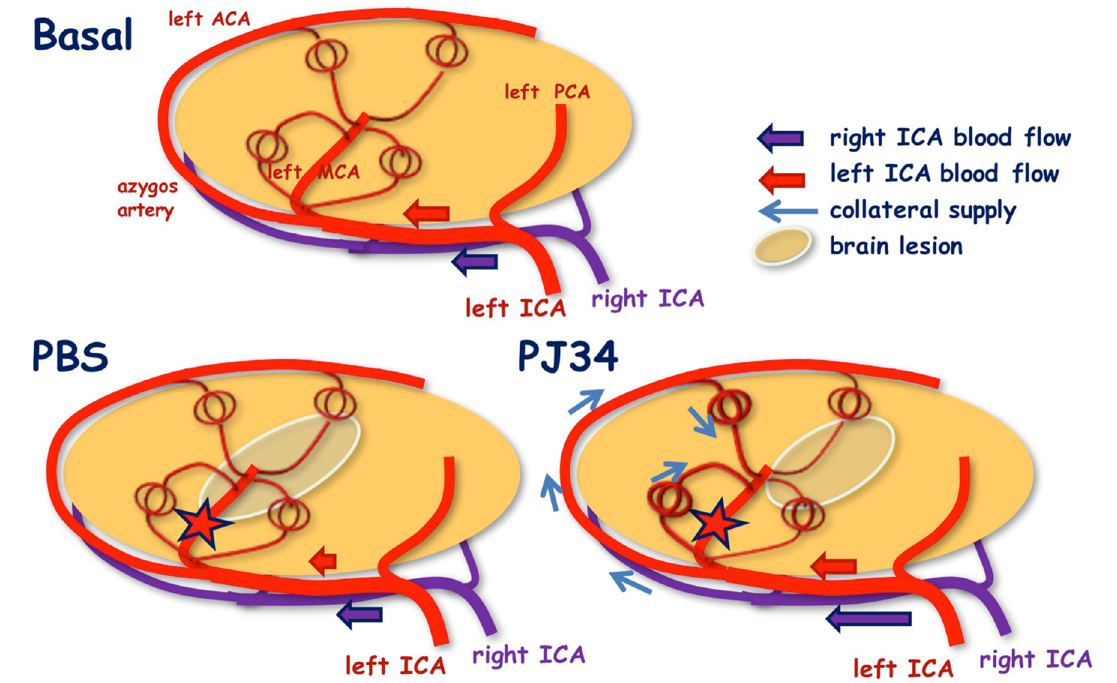
Figure 6. Schematic representation summarizing blood flow re-routing after pMCAo and treatment. After PBS, blood flow is reduced in the left ICA with no collateral flow. After PJ34, blood flow remained stable in the left ICA and increased in the right ICA, leading to collateral supply via the azygos artery. Red star represents the location of pMCAo, i.e., after the first side branches of the MCA.